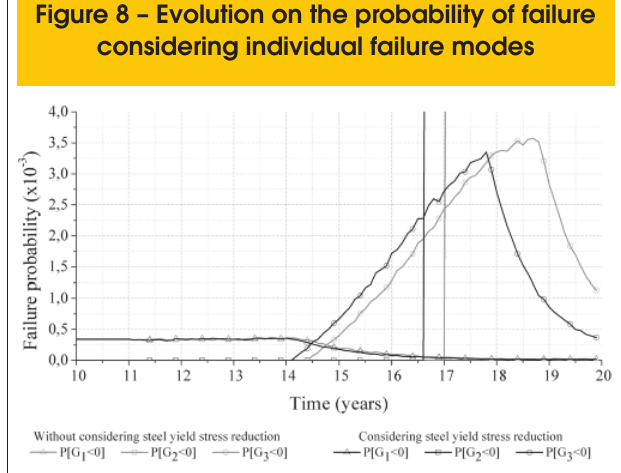
Figure 7 – Evolution on the rebar cross-section during the corrosion process